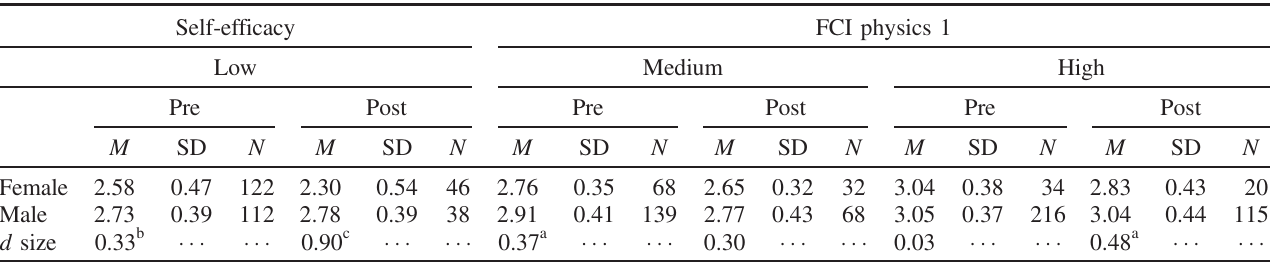
TABLE V. Self-efficacy scores in physics 1 binned by FCI scores (high, medium, low) for female and male students ( M ¼ mean, SD ¼ standard deviation, N ¼ number of students), along with Cohen ’ s d for the gender contrast in means. Self-efficacy